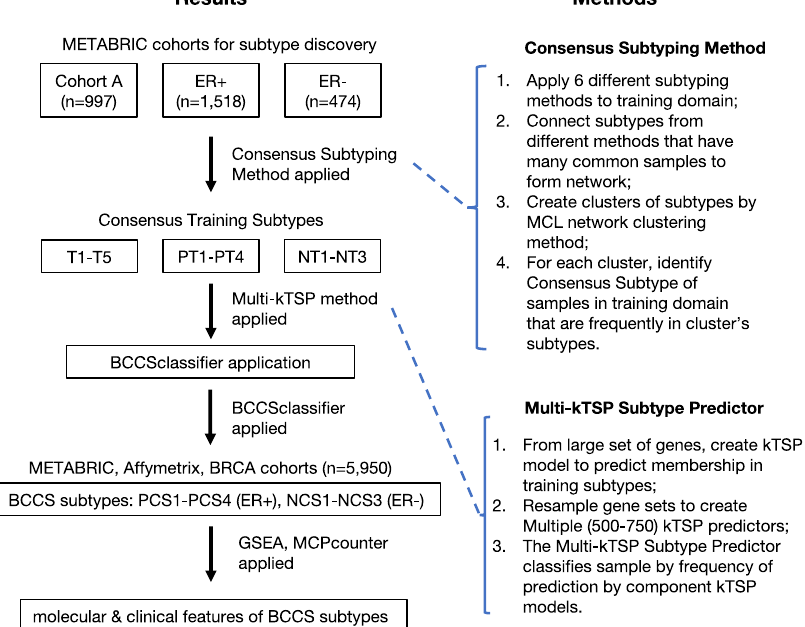
Fig. 1 Project work fl ow. The analysis work fl ow for the project is diagramed, describing both the results and the novel methods